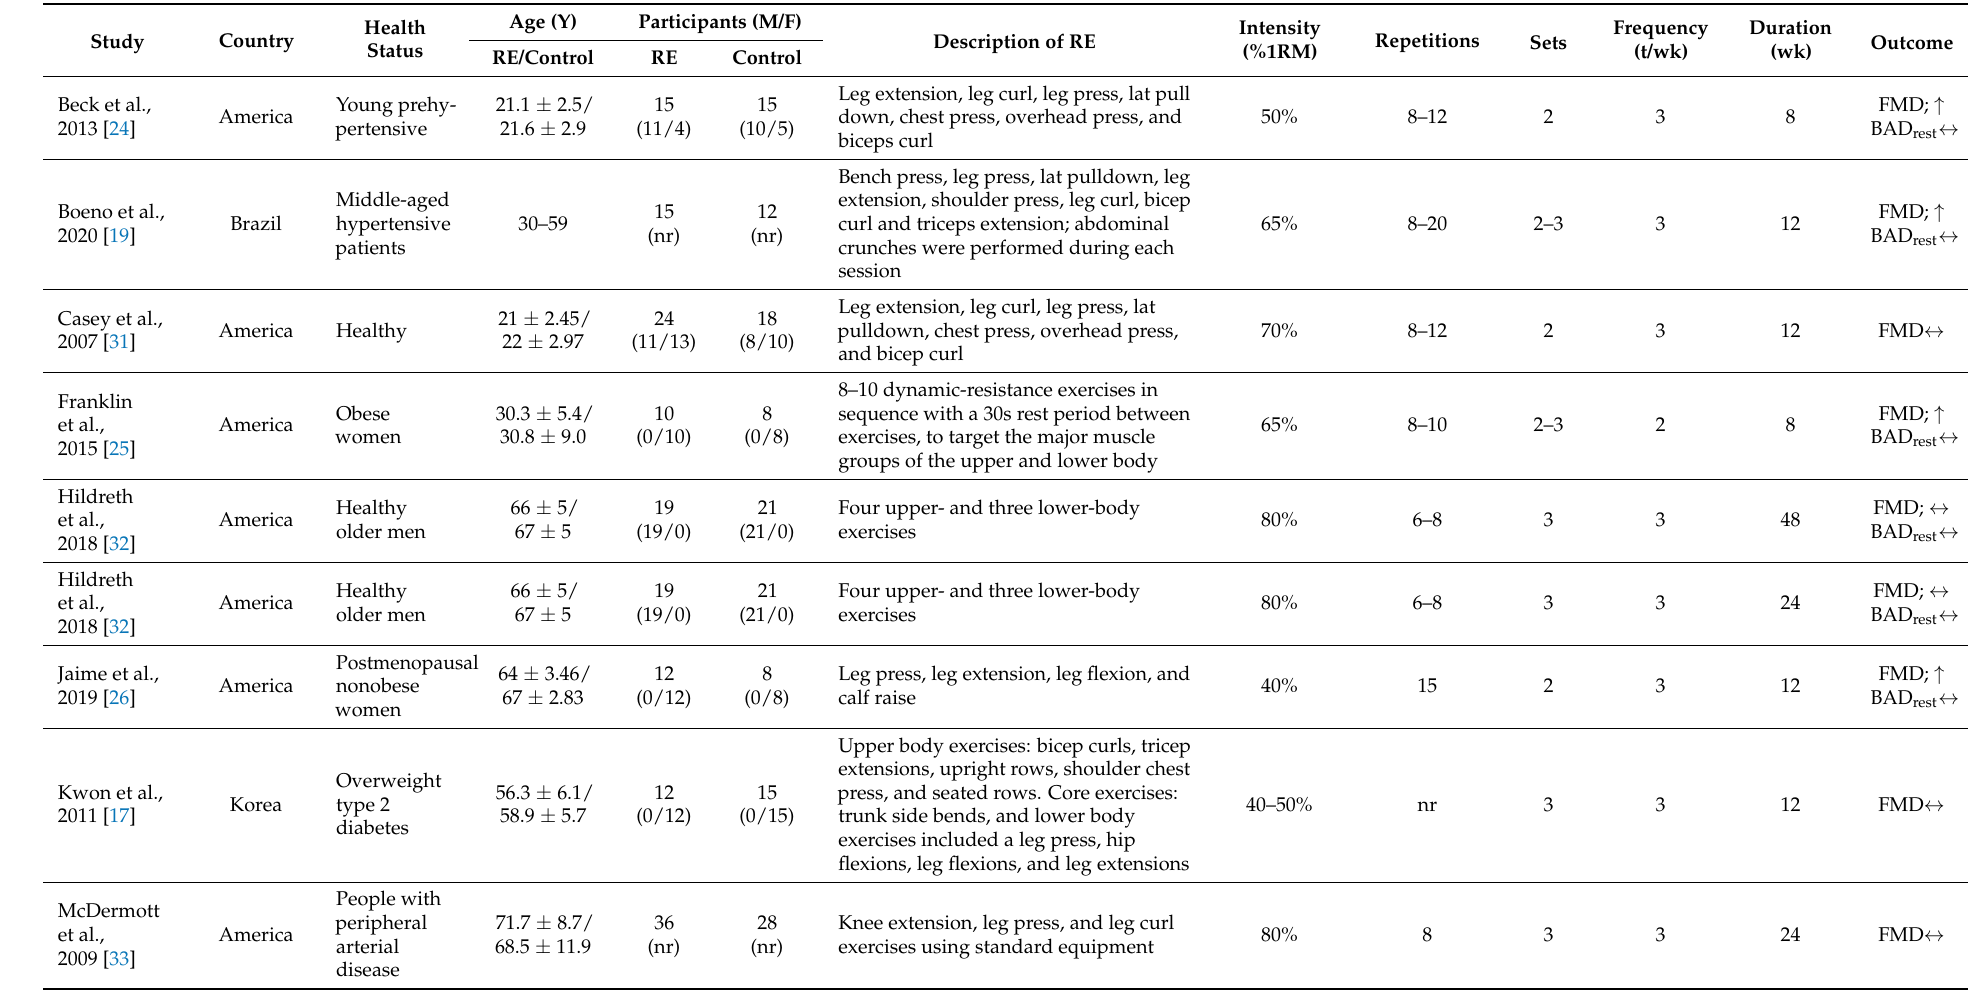
Table 1. Characteristics of the included studies.